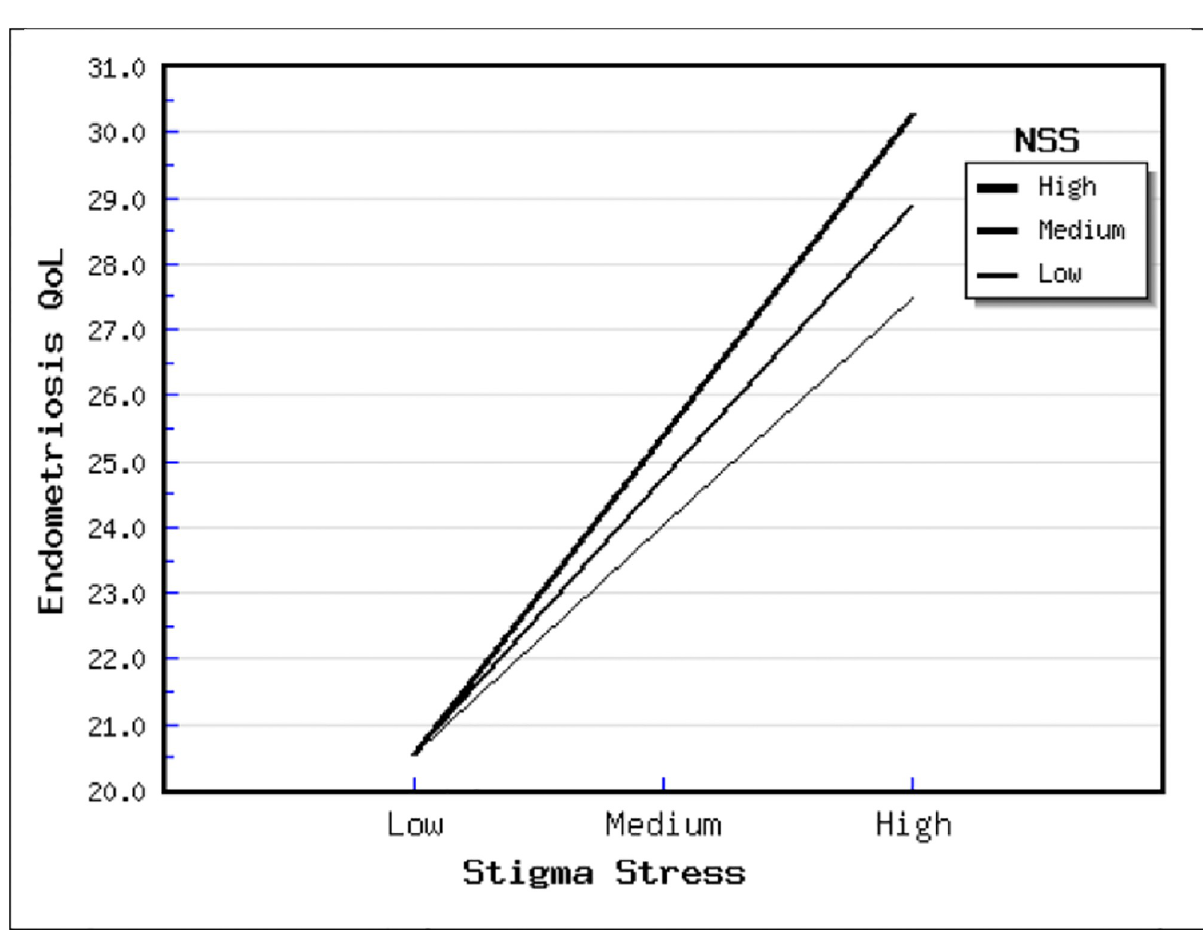
Fig 2. Moderating effect of need for social support in the relationship between stigma stress and endometriosis QoL.